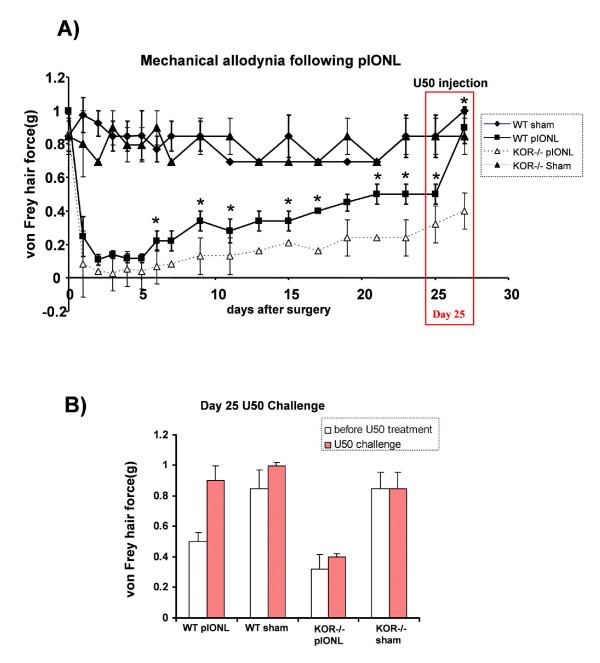
(A) Response thresholds of ipsilateral whisker pad to usually innocuous tactile (von Frey Hair) stimuli in WT sham, WT pIONL, KOR-/- sham, and KOR-/- pIONL mice during 25 days after partial infraorbital nerve ligation. After pIONL, both WT and KOR-/- mice developed allodynic response as evident from the decreased thresholds to tactile stimulation compared with WT and KOR-/- mice that received sham-ligation surgeries. One week after pIONL, WT mice with pIONL began to show the increase of the mechanical threshold, whereas KOR-/- pIONL group showed much slower recovery and significantly greater allodynic response than WT pIONL group. (B)On the 25th day after surgery, we injected the kappa opioid receptor agonist U50,488 intraperitoneally at 10 mg/kg in each group of mice. The von Frey hair force returned to baseline in WT pIONL group, but not in KOR-/- pIONL group. U50,488 injection did not affect the mechanical threshold in sham operated groups. Asterisks indicate significant decreases in the threshold to stimuli by the von Frey hair applied to ipsilateral side of whisker pad in KOR-/- pIONL group compared to WT pIONL group (p < 0.05, ANOVA followed by Student-Newman test). Data are presented as the mean ± SEM von Frey hair threshold in grams; n = 8 per time point).